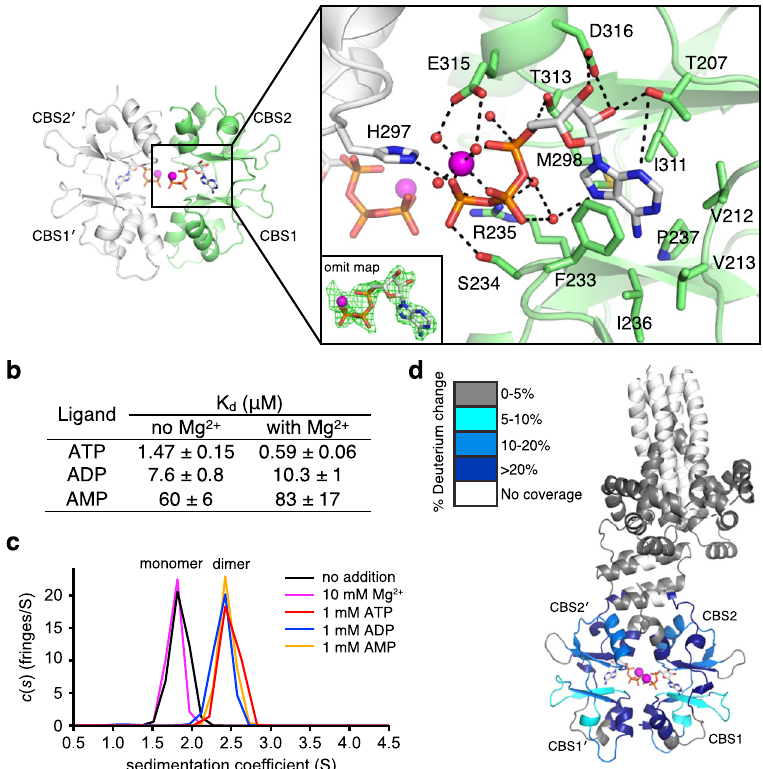
Fig. 4 Mg 2 + -ATP binding to CBS-pair domain. a Structural basis of Mg 2 + -ATP binding. Mg 2 + ions and water molecules are shown in magenta and red , respectively. The Mg 2 + -ATP F o – F c omits map was contoured at 3.0 σ . b Af fi nities of MtCorB Δ C to adenosine nucleotides with and without 50 mM Mg 2 + measured by ITC. c Dimerization of the MtCorB CBS-pair domain in the presence of 1 mM adenosine nucleotides as measured by SV-AUC experiments. d Conformational change in the MtCorB Δ C in the presence and absence of Mg 2 + -ATP measured by HDX-MS. Regions that showed signi fi cant decreases in exchange (de fi ned as >5%, 0.4 Da, and a two-tailed Student ’ s t test p < 0.01) in the presence of Mg 2 + -ATP are colored blue. Peptides in the CBS-pair domain dimerization interface show the most protection from deuterium exchange upon Mg 2 + -ATP